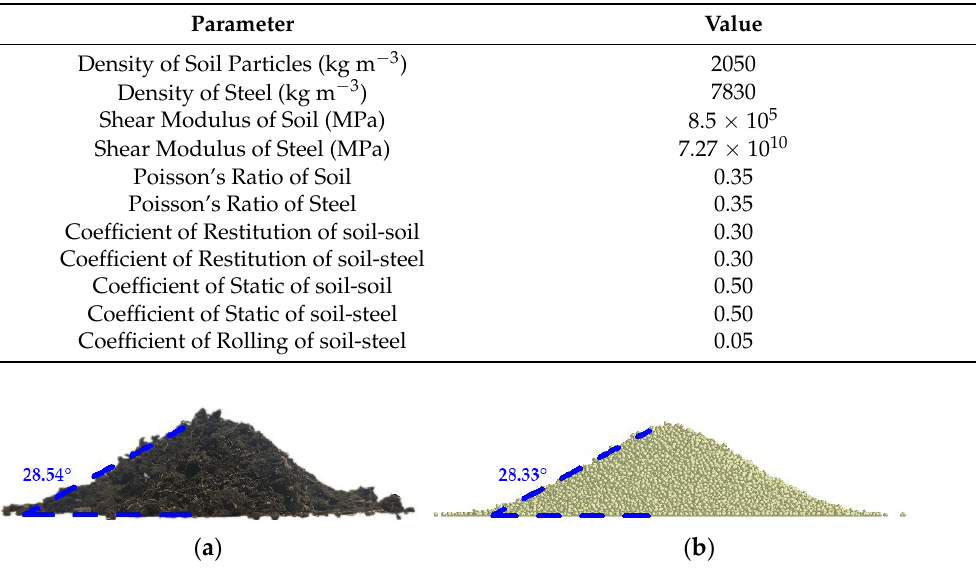
Table 5. Simulation parameters of the discrete element simulation test.